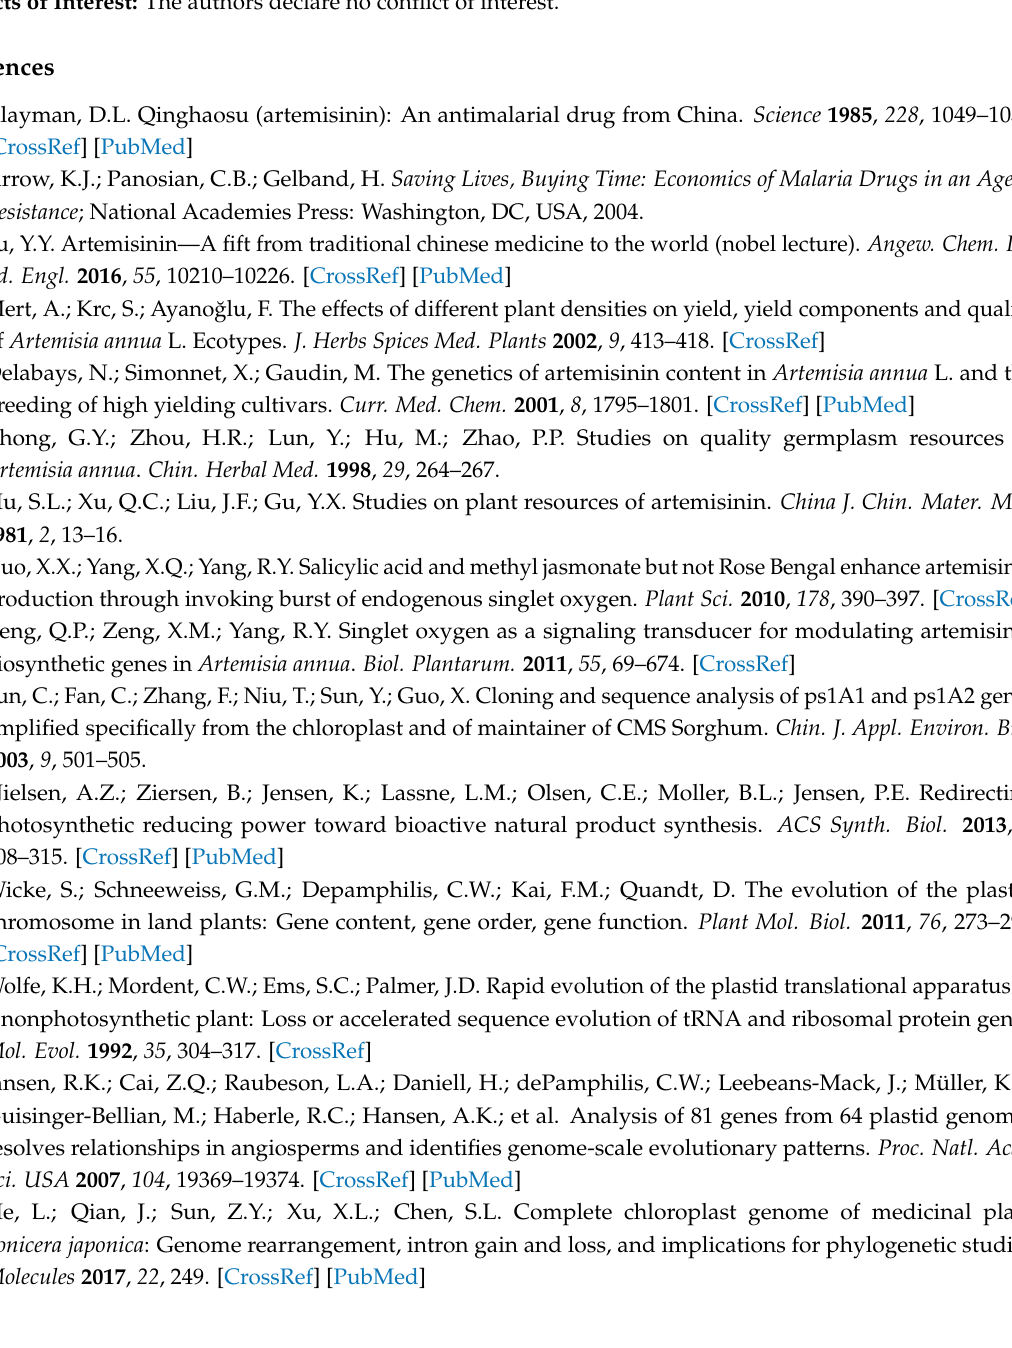
Table S2. Size comparison of Artemisia annua chloroplast genomic regions and three other Asteraceae chloroplast genomes. Table S3. Size comparison of Artemisia annua chloroplast genomic regions and three other Artemisia chloroplast genomes. Table S4. Primers used for assembly validation. Figure S1. Chloroplast genomic alignment between Artemisia annua and Artemisia frigida . Figure S2. Chloroplast genomic alignment between Artemisia annua and Artemisia fukudo . Figure S3. Chloroplast genomic alignment between Artemisia annua and Artemisia montana